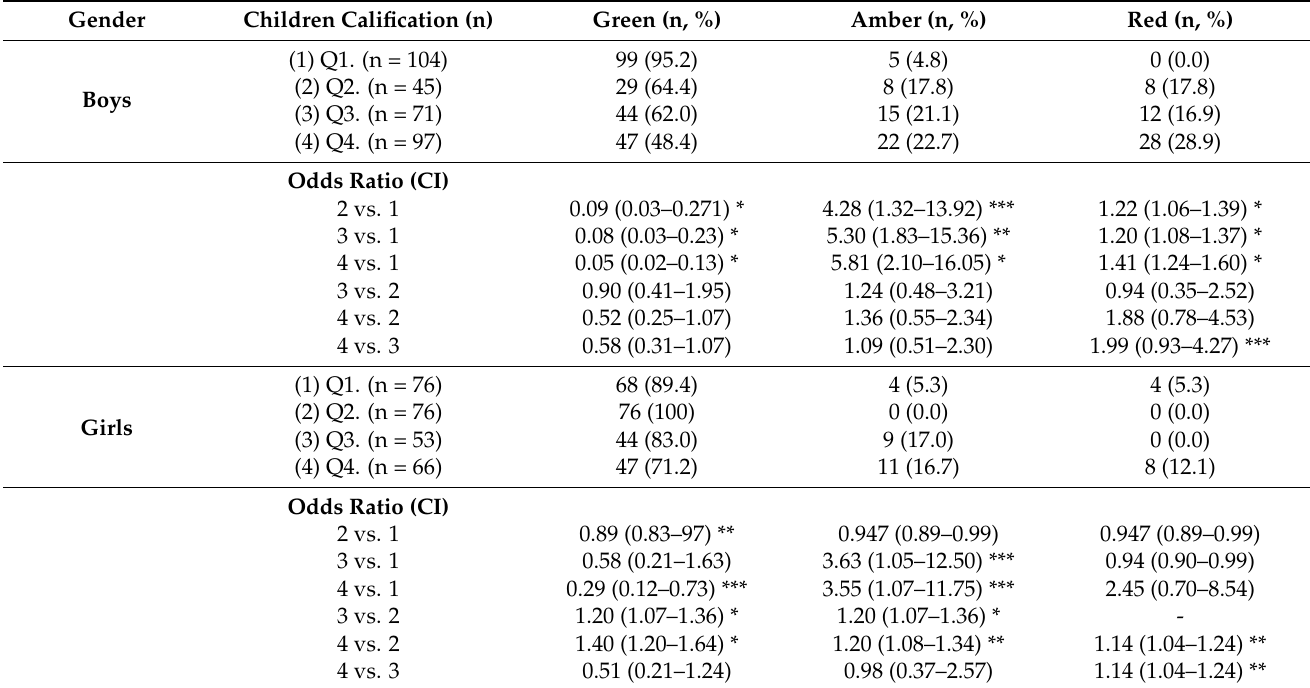
Table 3. Preschool children according to gender, quarter of birth, and traffic light zone of the MABC-2 battery. Gender Children Calification (n) Green (n, %) Amber (n, %) Red (n,